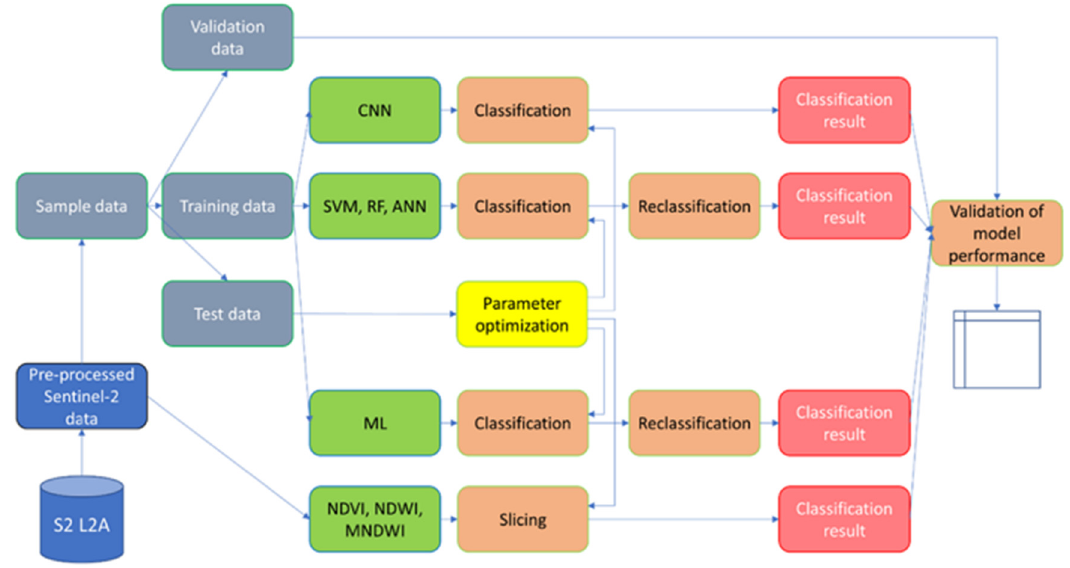
Figure 2. Workflow for the evaluation of the optimal methodology for water delineation.